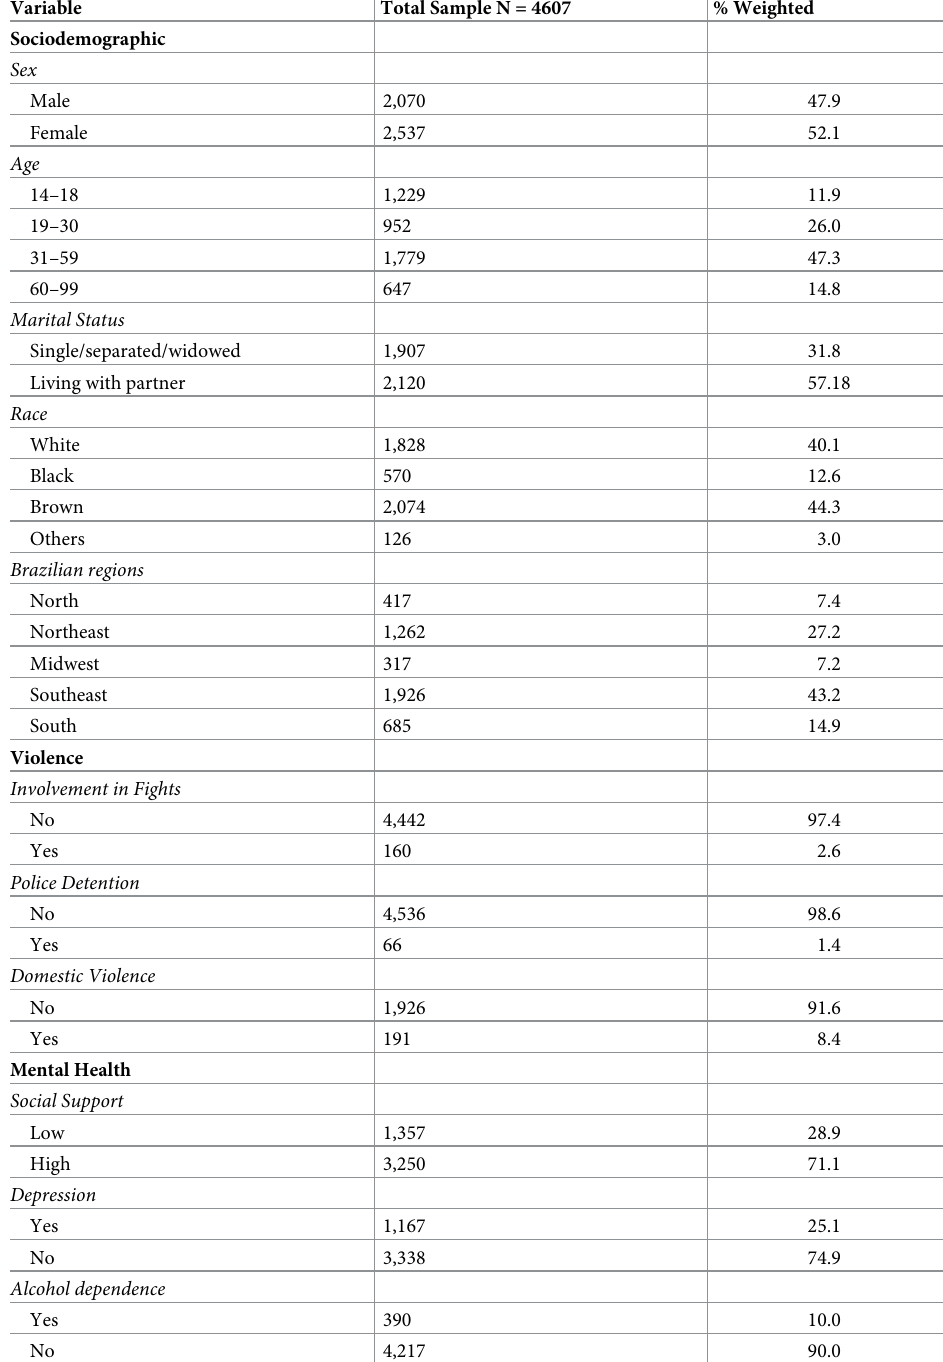
Table 1. Characteristics of sociodemographic, violence and mental health